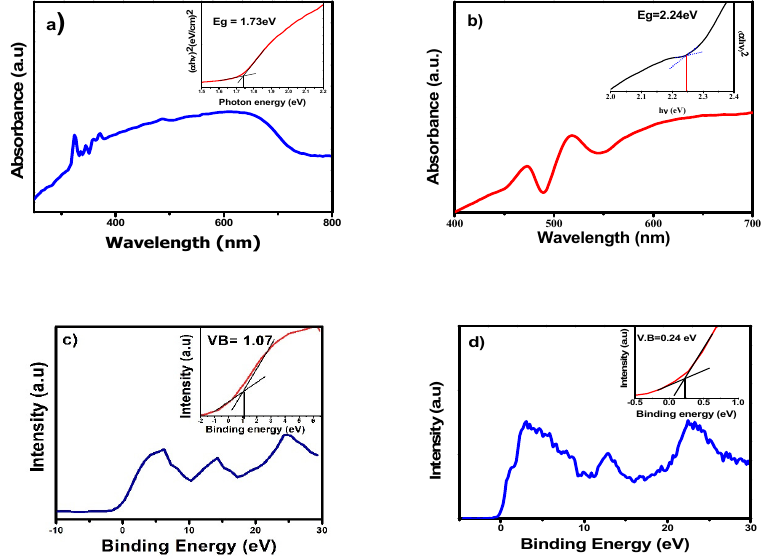
Figure 4. UV–vis-DRS spectrum of ( a ) MoS 2 , ( b ) CoTe with insets showing the respective Tauc plots and band gap of MoS 2 and CoTe. ( c ) MoS 2 and ( d ) CoTe are the XPS spectra for valence band positions in the corresponding insets.